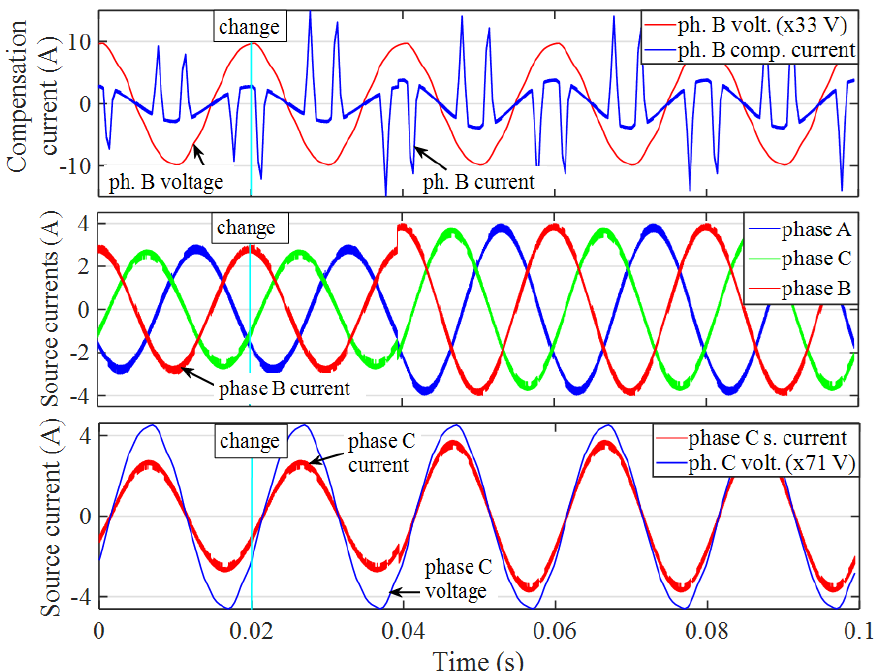
Figure 17. Experimental dynamic performance including load unbalance. Change at time t = 0.02 s. Top graph: compensation current and voltage waveform. Middle graph: source currents, showing balanced waveforms both before and after the load change. Bottom graph: source current and voltage, showing the power factor correction. Table 3. Some features of the reference works, with control methods based on different ANN types. ANN